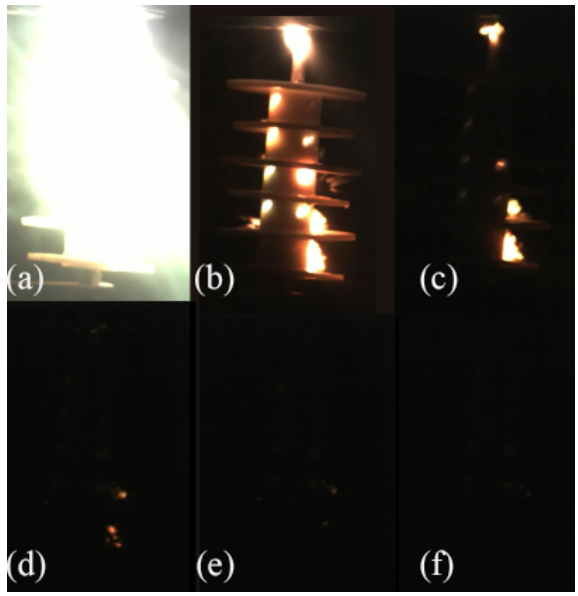
Figure 11. Arc-extinguishing process captured by high-speed camera.